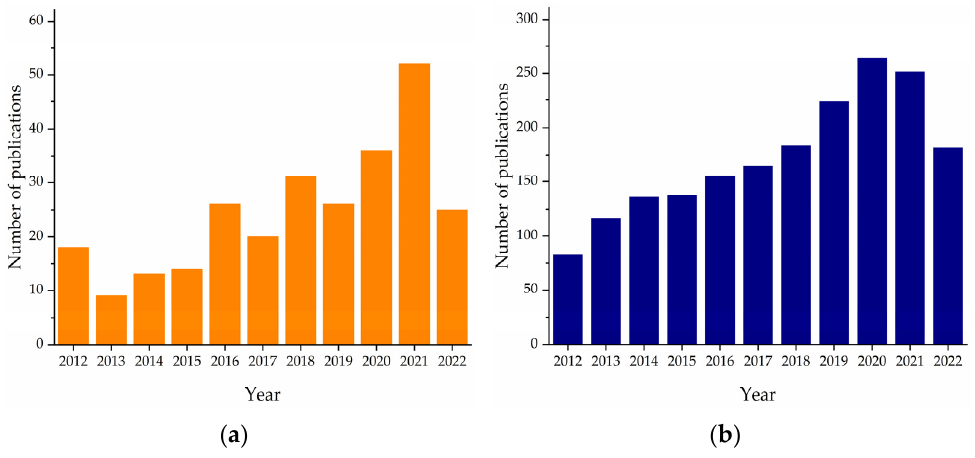
Figure 1. Number of publications from 2012 to 2022 of ( a ) PODS and ( b ) ODS. Data from Scopus from 12 July 2022 (keywords are ‘photocatalytic desulfurization’, ‘oxidative desulfurization’).